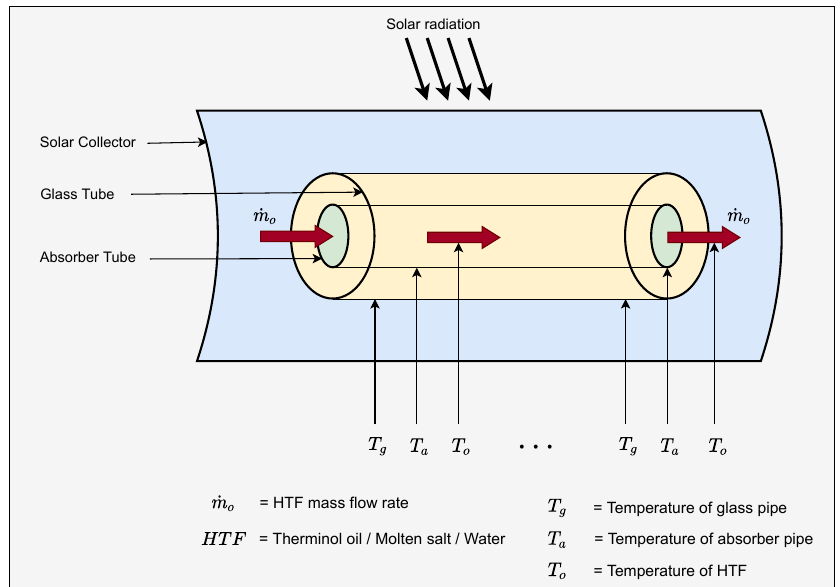
Figure 1. Parameters and dynamic variables of PTCTHO and PTCMS.